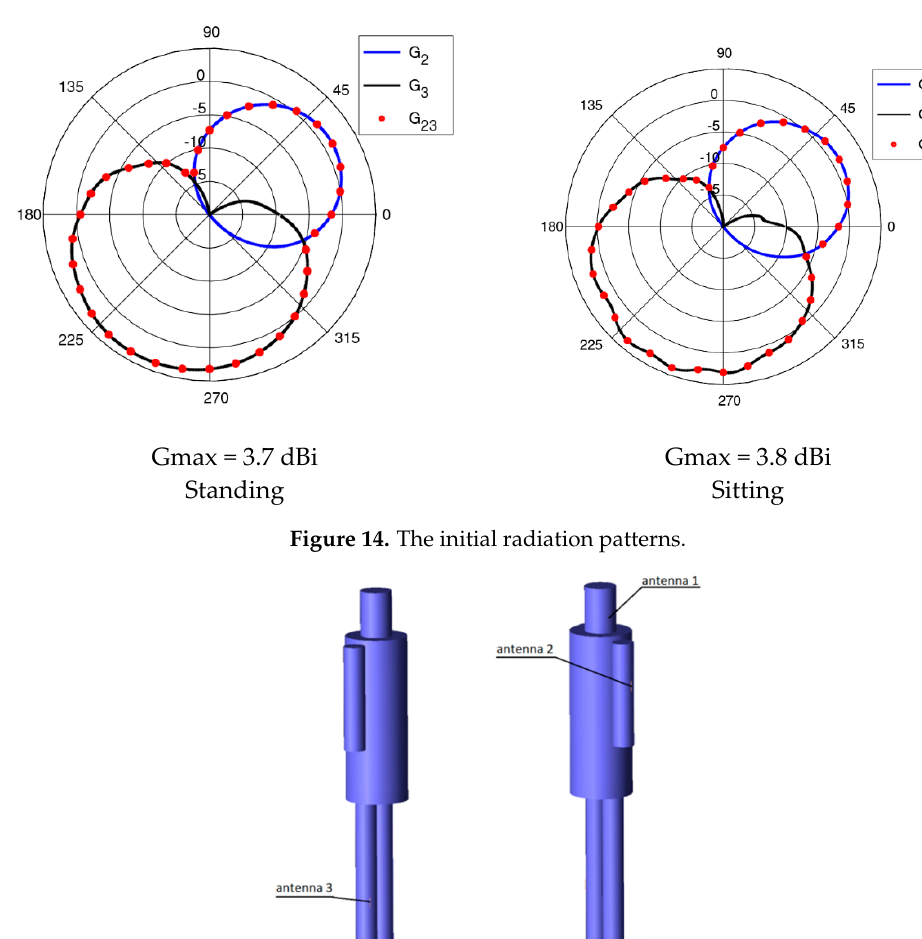
Figure 15. The final placement of the antennas on the standing model.